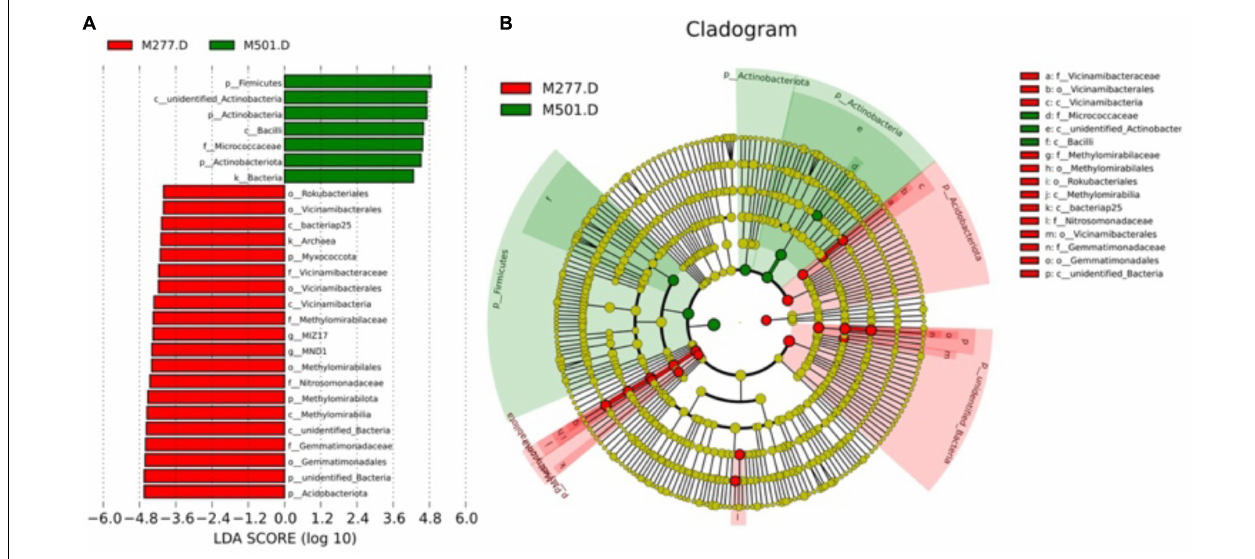
FIGURE 10 | LEfSe analysis of soil samples. (A) Linear discriminant analysis (LDA) effect quantity distribution between different groups, the X -axis represents LDA score (log10), Y -axis indicates significantly different bacteria (LDA > 4.0). (B) The arc diagram of taxonomic evolutionary branches with significant differences between the two groups shows the subordination of different genera from the inside out. The node size corresponds to the average relative abundance of different genera. The red area is the distribution area of different genera in the M277.D group and the green area is the distribution area of different genera in the M501.D